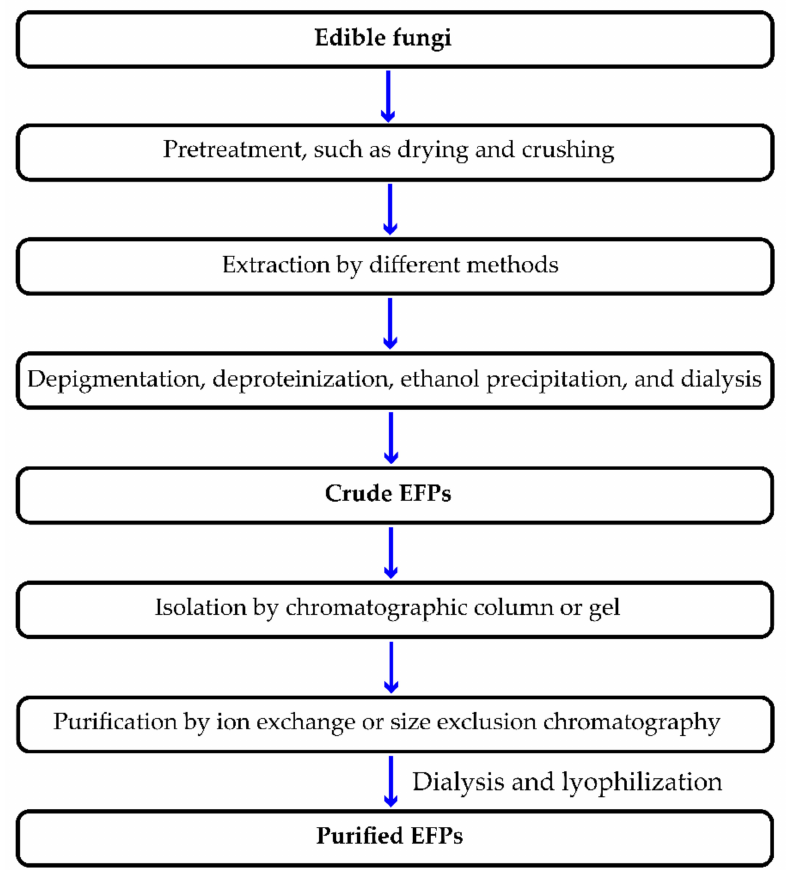
Figure 1. Preparation process of